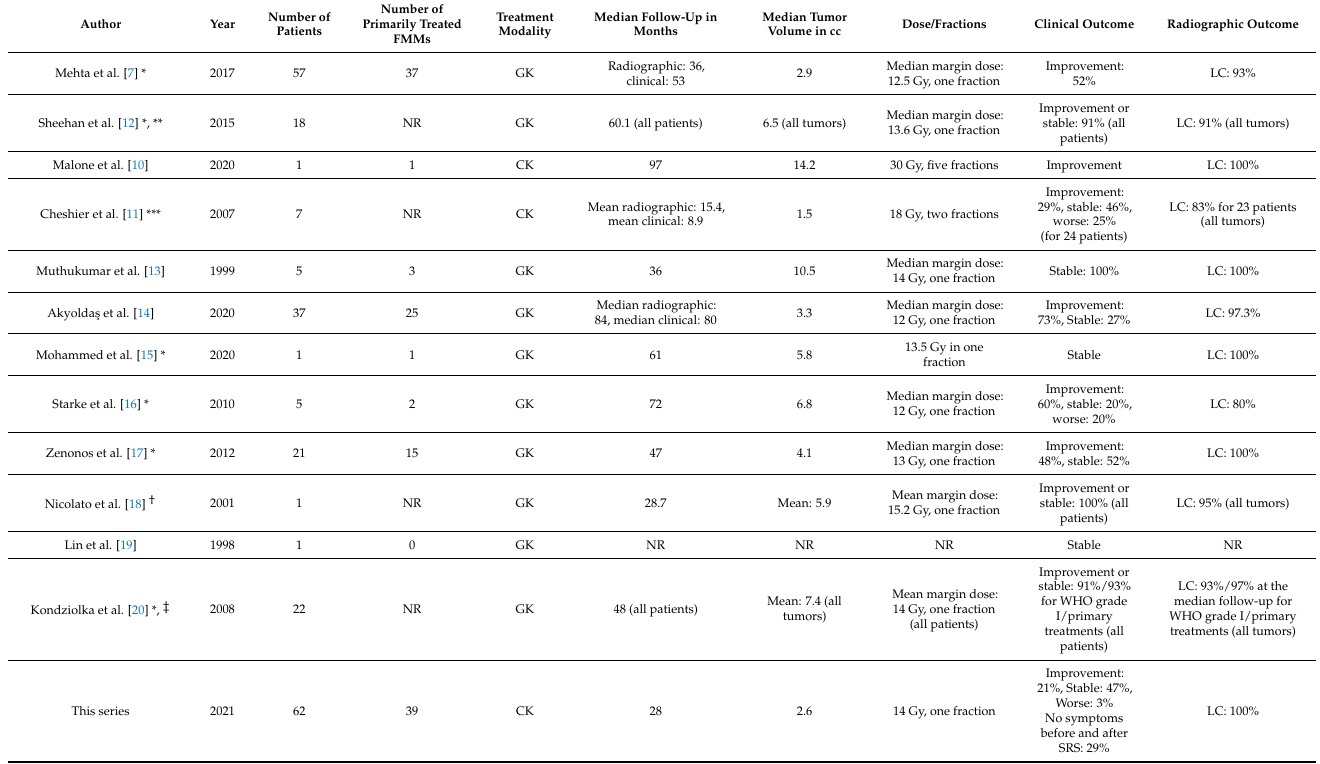
*: Overlapping data from same institutions, **: Study included a total of 675 posterior fossa meningiomas, ***: Study included 18 other benign and 10 malignant tumors, † : Study included a total of 57 patients with 62 posterior fossa meningiomas, ‡ : Study included a total of 972 patients with 1045 intracranial meningiomas. NR = Not reported, CK = CyberKnife, GK =